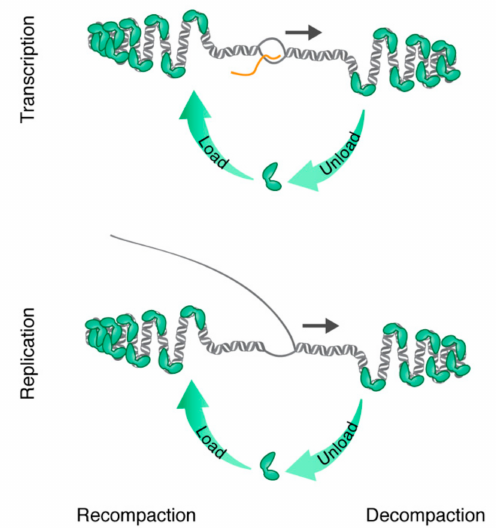
Figure 4. Dynamics of TFAM binding during transcription and replication. Model of how nucleoid decompaction and re-compaction facilitate transcription (upper panel) and replication (lower panel). TFAM (green) unloads from the DNA (grey duplex) ahead of the transcription bubble or replication fork to enable progression (dark arrows) of the transcription and replication machineries. TFAM may then reload directly behind in order to recompact the